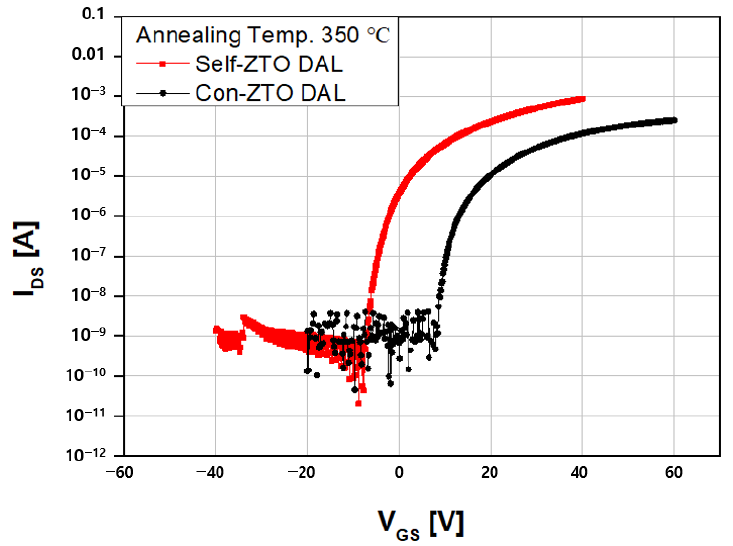
Figure 5. Transfer characteristic curves of con-ZTO DAL and self-ZTO DAL TFTs at an annealing temperature of 350 °C for 1 h.